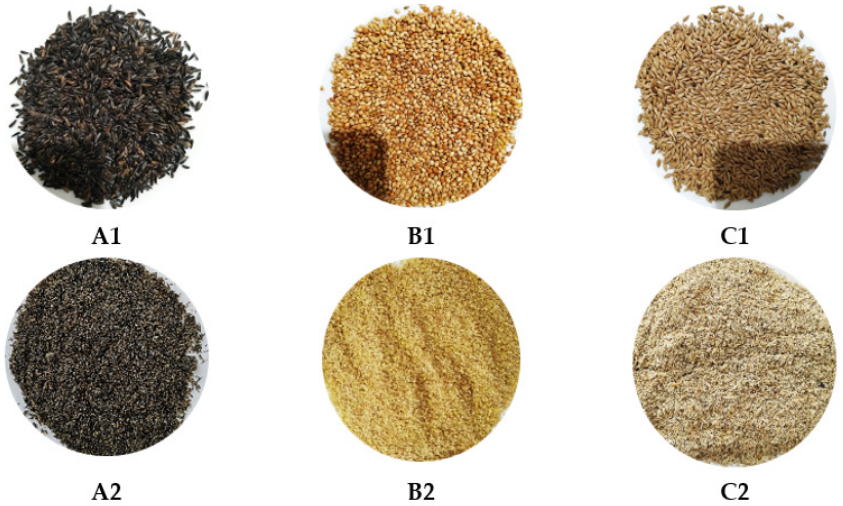
Figure 1. Niger ( A1 ), millet ( B1 ) and birdseed ( C1 ) seeds and the corresponding flours ( A2 , B2 and C2 , respectively).